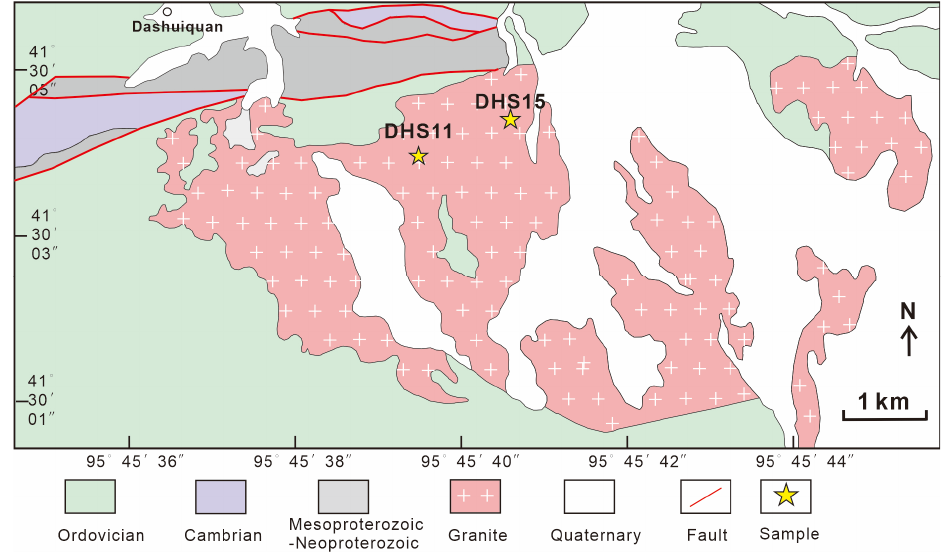
Figure 2. Geological map of the study area in the middle Huaniushan arc (modified from 1: 50,000 geological maps of the Duhongshan area).